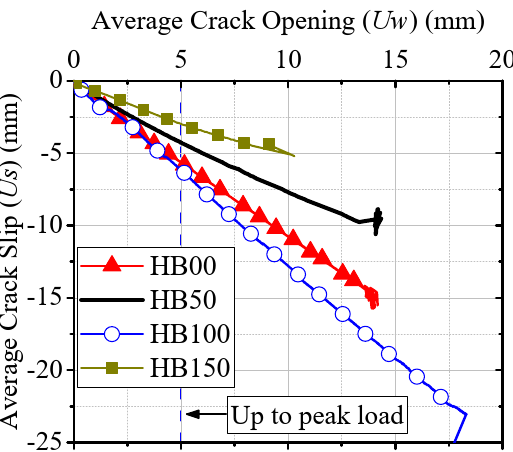
Figure 12. Average crack opening ( U w ) versus crack slip ( U s ) up to an ultimate load point.